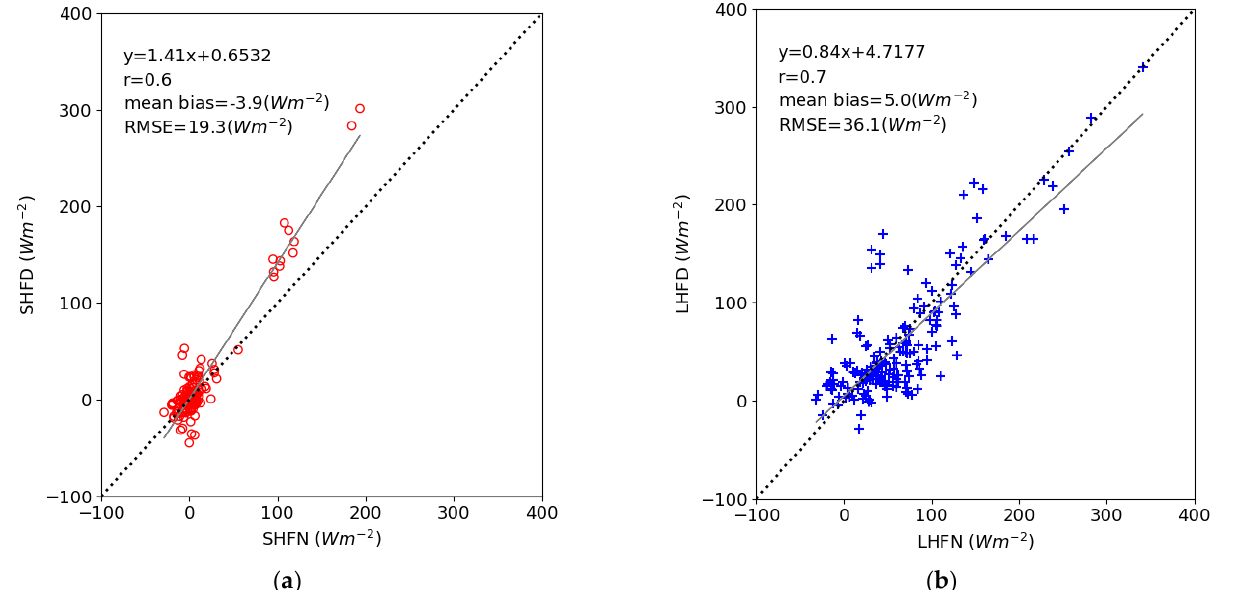
Figure 6. Comparison of dropsonde-based SHF (SHFD) and dropsonde-based LHF (LHFD) with model-based sensible heat flux (SHFN) and model-based latent heat flux (LHFN), respectively. ( a ) sensible heat flux ( b ) latent heat flux.